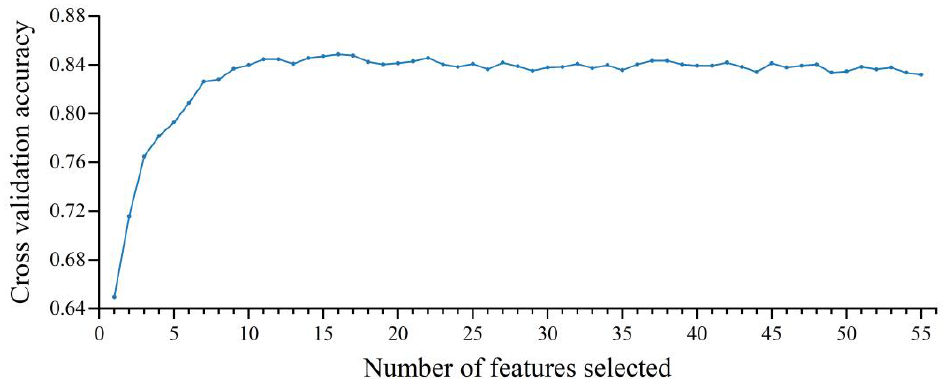
Figure 4. Recursive feature elimination of 55-dimensional features.